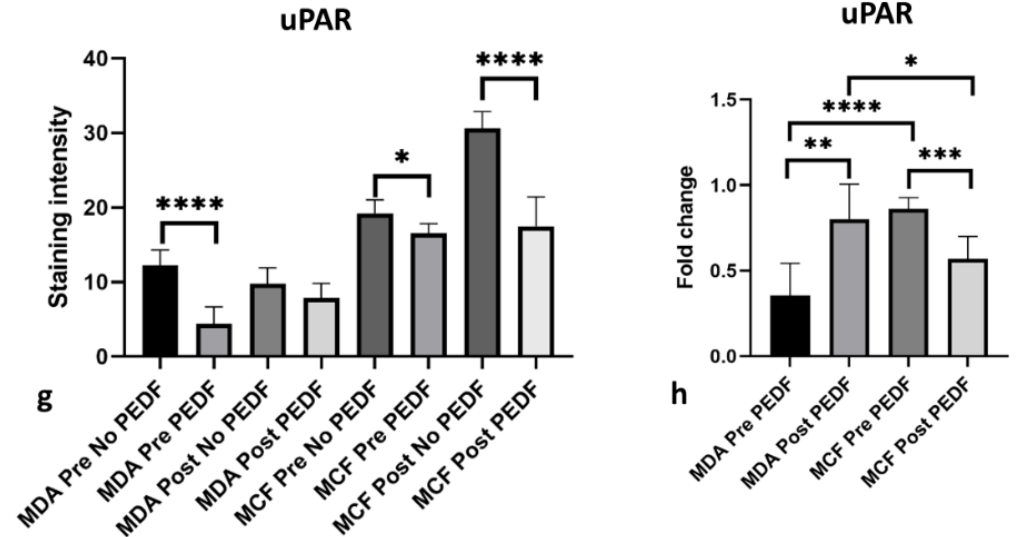
Figure 1. Biomarker immunocytochemistry in MCF-7 and MDA-MB-231 cells following PEDF treatment in pre- versus post-menopausal oestrogens . Biomarker expression via immunocytochemistry staining (blue) in MCF-7 and MDA-MB-231 cells following incubation in media supplemented with either pre-menopausal (E1: 258 pM; E1S: 4130 pM; E2: 271 pM) or post-menopausal (E1: 72 pM; E1S: 541 pM; E2: 14.6 pM) oestrogen levels and treated with recombinant PEDF (100 nM) or control for 24-h. CXCR4 staining under pre-menopausal conditions in MCF-7 treated with control ( A ) or PEDF ( B ) and in MDA-MB-231 treated with control ( E ) or PEDF ( F ), or under post-menopausal conditions in MCF-7 treated with control ( C ) or PEDF ( D ) and in MDA-MB-231 treated with control ( G ) or PEDF ( H ). Phosphorylated (p-)NF κ B-p65 staining under pre-menopausal conditions in MCF-7 treated with control ( I ) or PEDF ( J ) and in MDA-MB-231 treated with control ( M ) or PEDF ( N ), or under post-menopausal conditions in MCF-7 treated with control ( K ) or PEDF ( L ) and in MDA-MB-231 treated with control ( O ) or PEDF ( P ). TNF- α staining under pre-menopausal conditions in MCF-7 treated with control ( Q ) or PEDF ( R ) and in MDA-MB-231 treated with control ( U ) or PEDF ( V ), or under post-menopausal conditions in MCF-7 treated with control ( S ) or PEDF ( T ) and in MDA-MB-231 treated with control ( W ) or PEDF ( X ). uPAR staining under pre-menopausal conditions in MCF-7 treated with control ( Y ) or PEDF ( Z ) and in MDA-MB-231 treated with control ( AC ) or PEDF ( AD ), or under post-menopausal conditions in MCF-7 treated with control ( AA ) or PEDF ( AB ) and in MDA-MB-231 treated with control ( AE ) or PEDF ( AF ). Biomarker staining intensity in cells treated with control or PEDF for CXCR4 ( a ), p-NF κ B-p65 ( c ), TNF- α ( e ), and uPAR ( g ). Biomarker fold change in PEDF-treated cells compared to control in pre- or post-menopausal conditions for CXCR4 ( b ), p-NF κ B-p65 ( d ), TNF- α ( f ), and uPAR ( h ). Scale bar 50 µM . **** p < 0.0001; *** p = 0.0001–0.0009; ** p = 0.001–0.009; * p = 0.01–0.05.